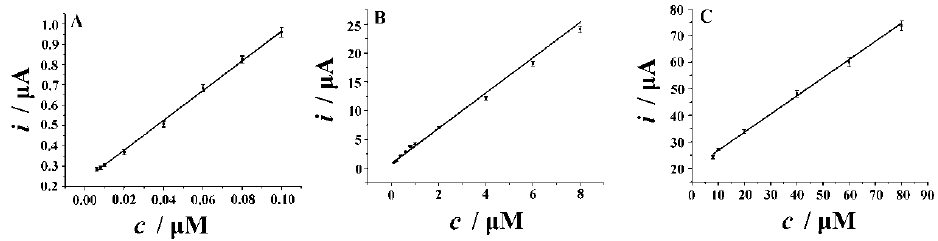
Figure 11. Plot of the peak current versus the concentration of rutin in the range from 6.0nM – 0.1 µM ( A ); 0.1–8.0 µM ( B ) and 8.0–80 µM ( C ). Accumulation potential: − 0.3 V, accumulation time: 210 s, scan ( A ); 0.1–8.0 µ M ( B ) and 8.0–80 µ M ( C ). Accumulation potential: − 0.3 V, accumulation time: 210 s, rate of 0.1 V/s. scan rate of 0.1